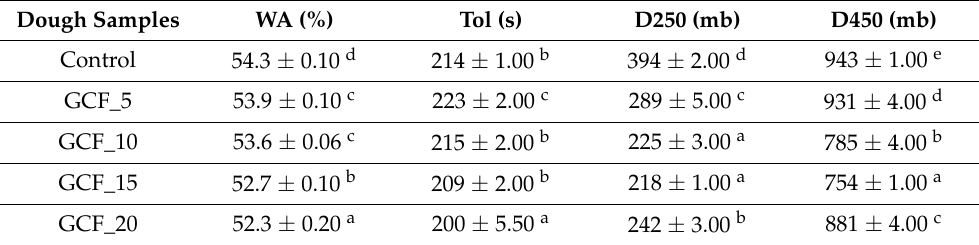
Table 1. Consistograph data of dough samples with different levels of GCF addition in wheat flour. Dough